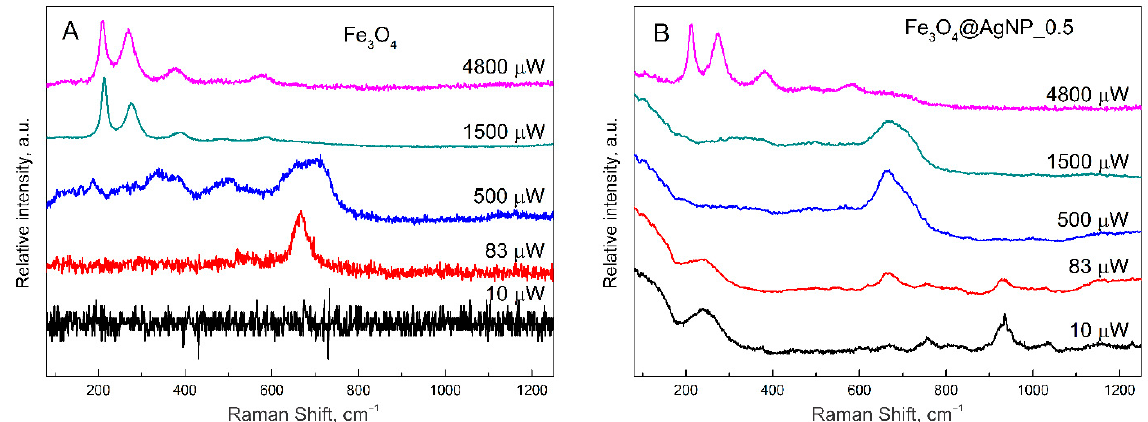
Figure 4. Raman spectra of ( A ) magnetite nanoparticles and ( B ) magnetite nanoparticles decorated with silver nanoparticles (Fe 3 O 4 @AgNP_0.5) at different laser powers from 10 µ W to 4.8 mW. Spectra were taken at 532 nm laser light on the nanoparticle samples dried on glass substrate.